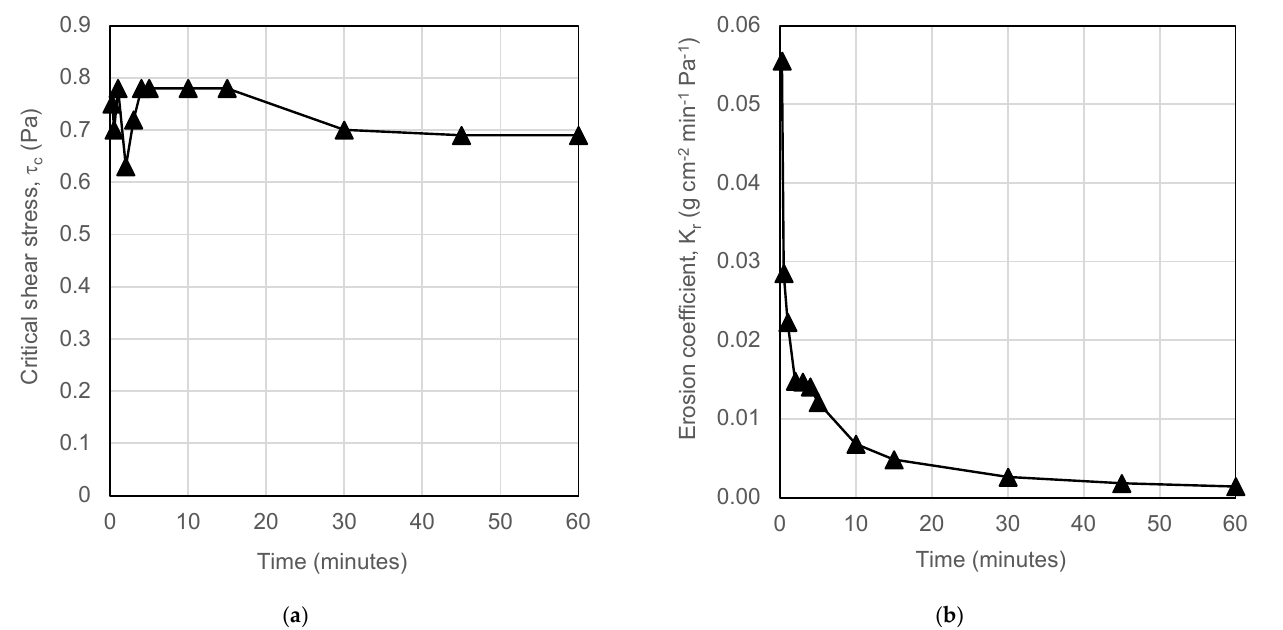
Figure 4. Evaluation of the time interval effect adopted in the definition of the parameters of the WEPP methodology ( w 0 = 18%, e = 1.5): ( a ) τ c ; ( b ) K r